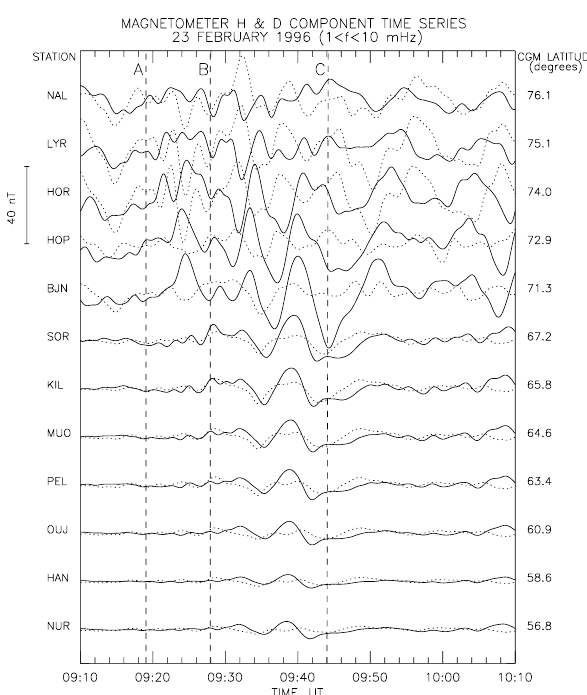
Fig. 6b. Expanded time series records for 09:10–10:30UT, where H -component is the solid line and D -component is the dotted line. Vertical dashed lines indicate events identified earlier.